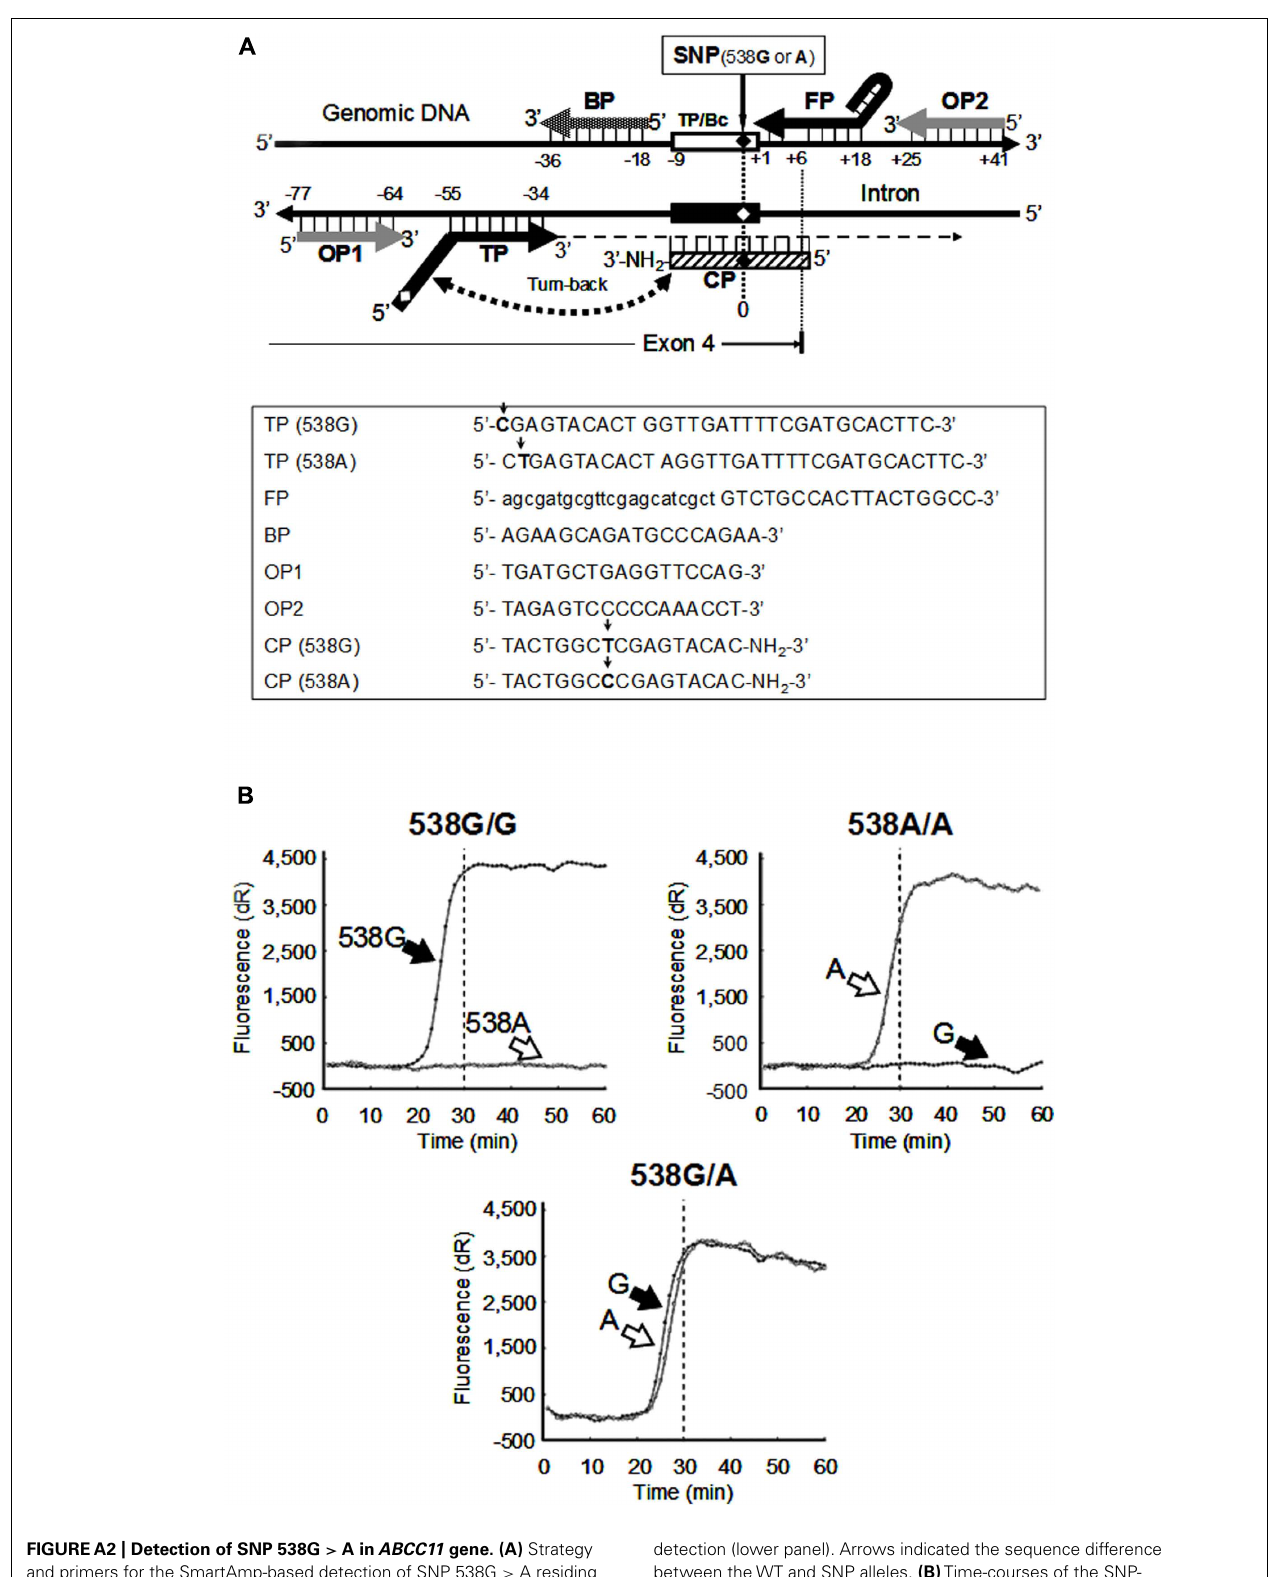
detection (lower panel). Arrows indicated the sequence difference between theWT and SNP alleles. (B) Time-courses of the SNP- detection reaction with ABCC11 allele-specific primers. Data are from Toyoda etal. (2009).